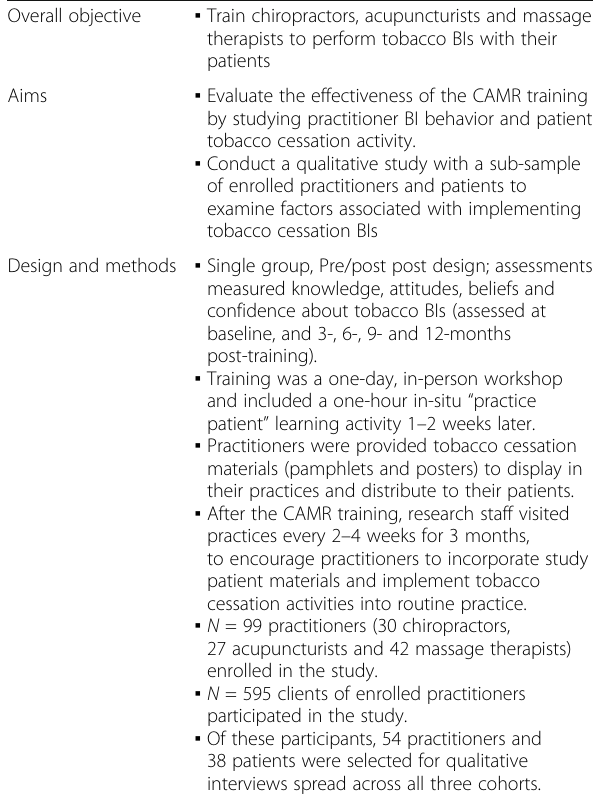
Table 1 Summary of CAMR study Overall